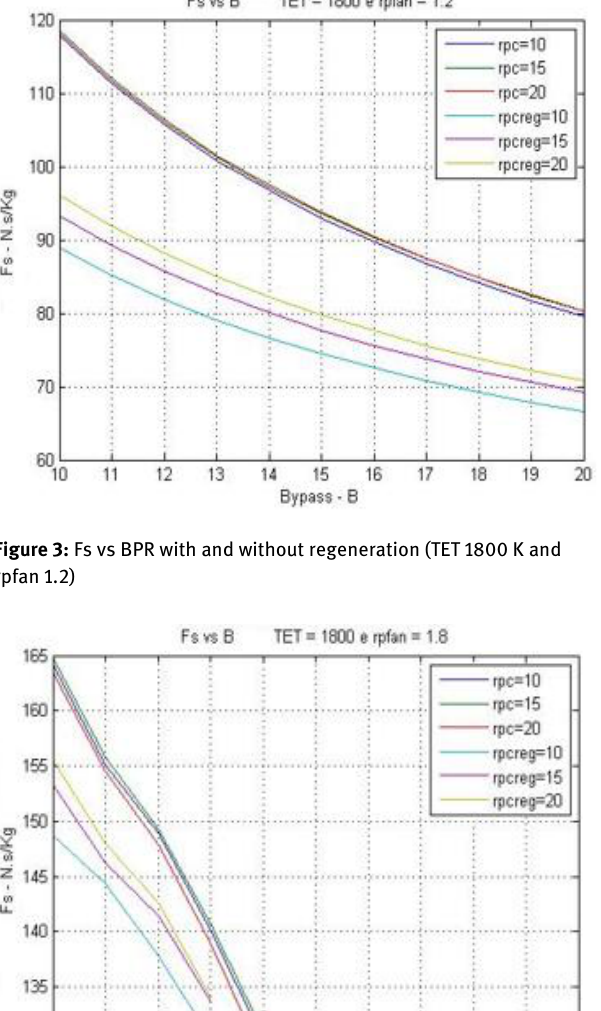
Figure 3: Fs vs BPR with and without regeneration (TET 1800K and rpfan 1.2) It is possible to state that the values of Fs increase as TET rises. However, the Fs decreases along with the BPR increase. For this TET, the rpc 20 shows the highest value of Fs and the lowest belongs to rpc 15. Regarding the regeneration results, the trend of the Fs curves for each rpcreg along all the BPR is equal to the situation without regeneration. However for each rpcreg, there are distinctive